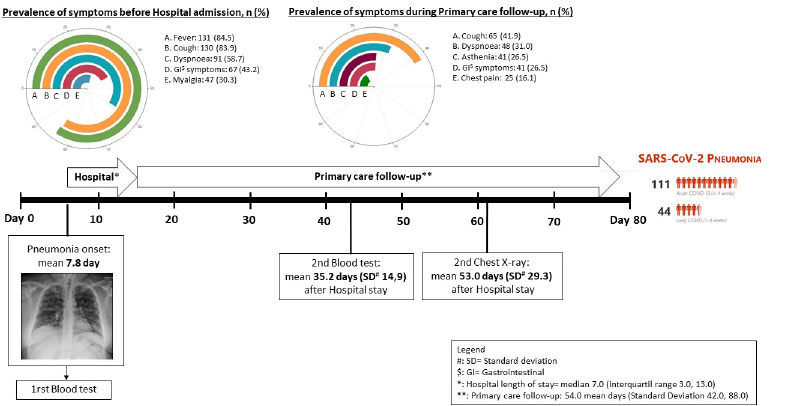
Fig 2. Clinical course of SARS-CoV-2 pneumonia 6 months follow-up in primary care (2020).